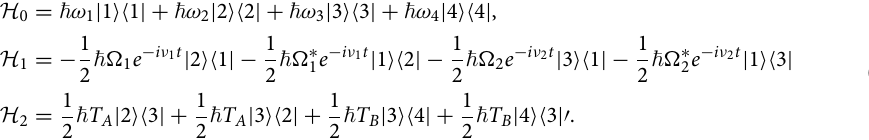
Here I 0 is the normalized intensity of the LG beam. Now the detailed form of Eq. (1) is given by